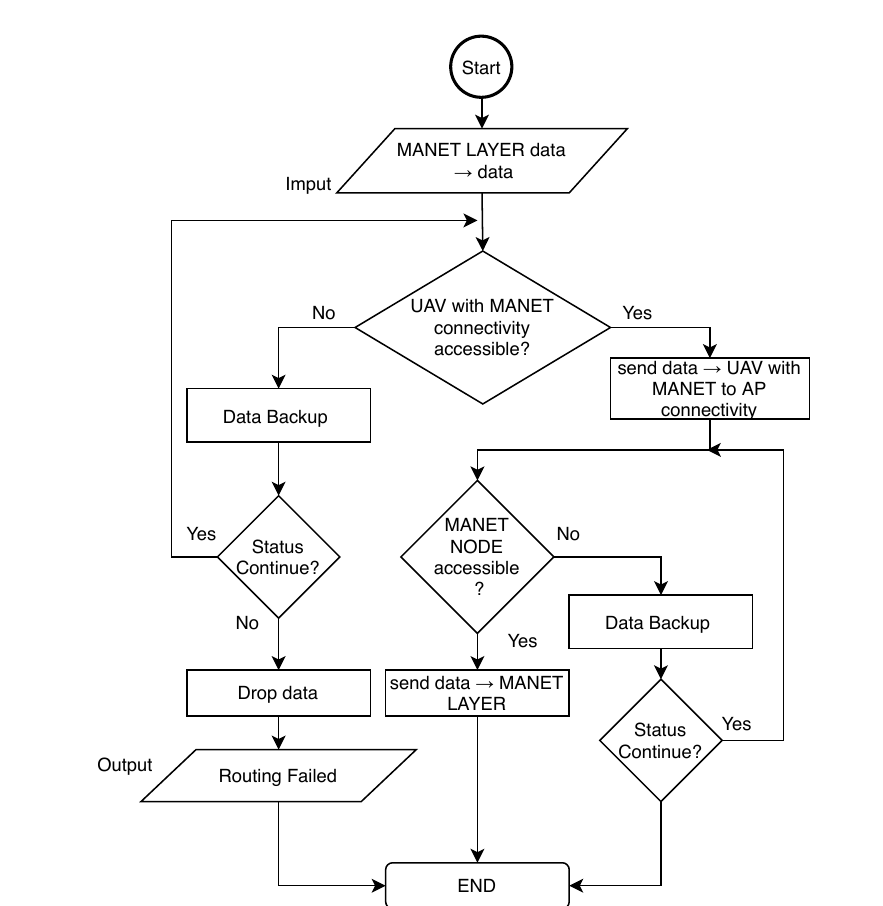
Figure 13. DRONET routing stage algorithm